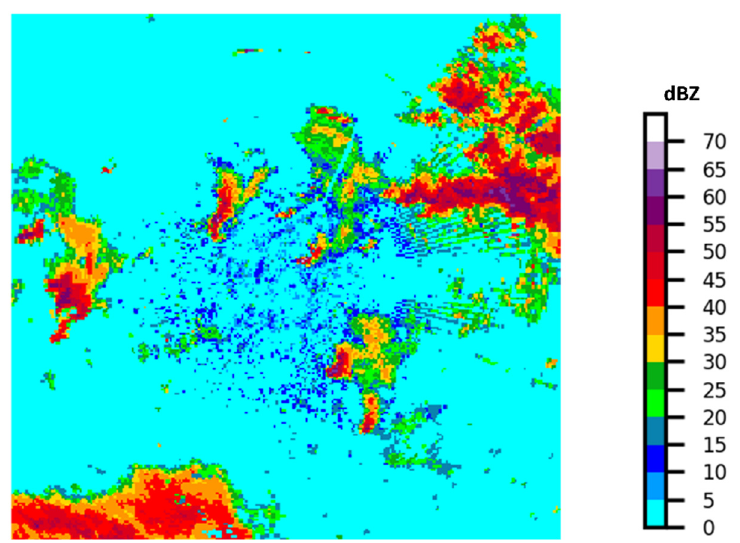
Figure 1. An example of radar echo image centered in Hong Kong City at 24 May 2015, 02:48:00